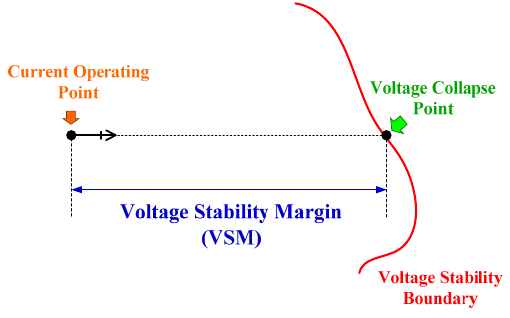
Figure 2. Illustration of Voltage Stability Margin ( VSM ).